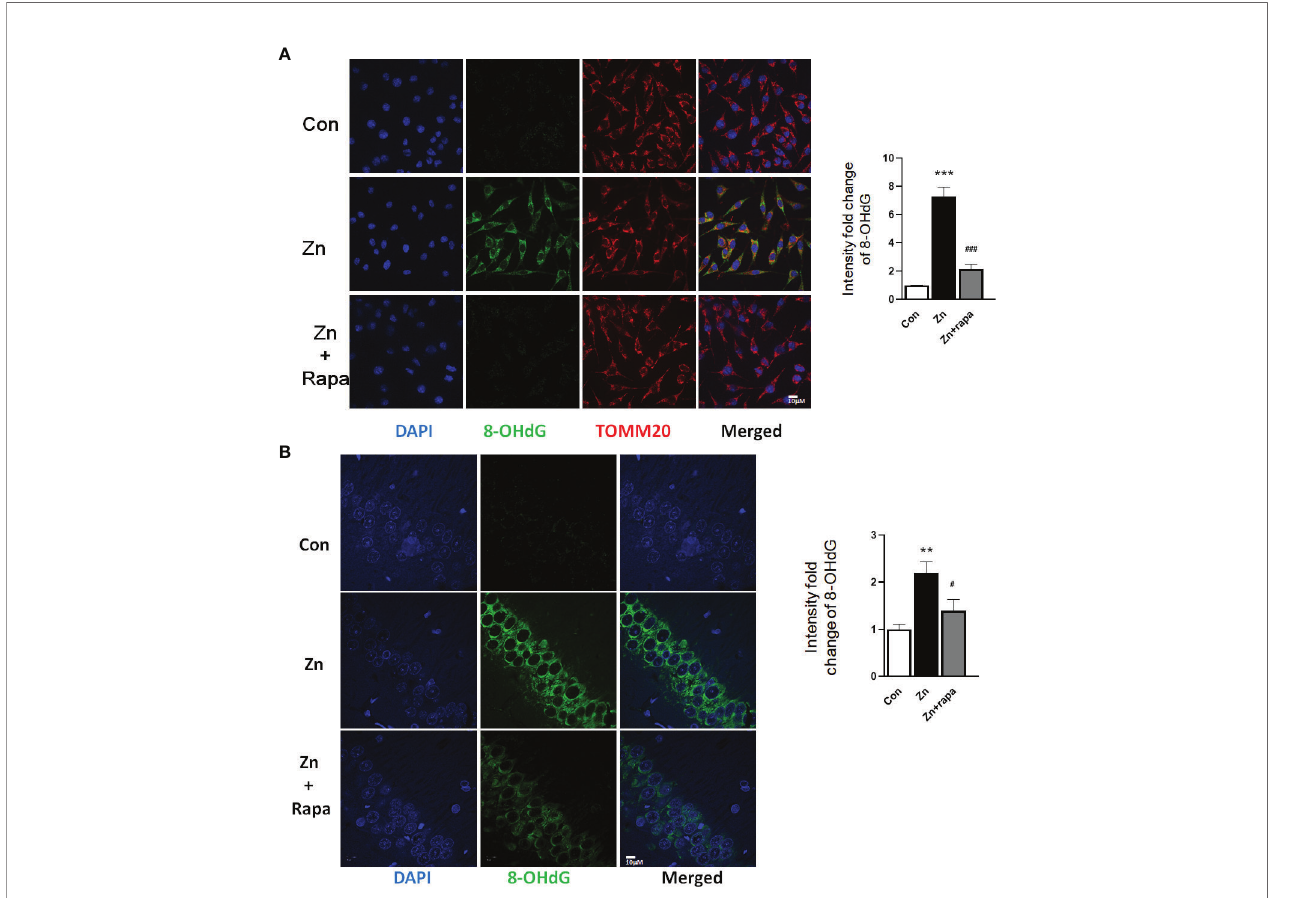
FIGURE 5 | Rapamycin prevents the DNA oxidation caused by zinc in SH-SY5Y cells and rats. (A, B) Representative confocal images and quanti fi cation of the fl uorescence intensity for immuno fl uorescence staining using anti-8-hydroxy-2 ’ -deoxyguanosine (8-OHdG) antibody (green) and anti-TOMM20 (red) in SH-SY5Y cells in the control, zinc, and zinc+rapamycin groups. Scale bar = 10 m m; nuclei were counterstained with DAPI (blue). Quanti fi cation of the fl uorescence intensity of 8- OHdG staining in the SH-SY5Y cells of the control, zinc, and zinc+rapamycin groups. n = 3 cell experiments per group. A total of 40 – 60 cells from each group were analyzed, and all confocal images are presented as the fold change relative to control cells. (C, D) Representative confocal images and quanti fi cation of the fl uorescence intensity for immuno fl uorescence staining using anti-8-OHdG antibody (green) in the CA1 areas of the brains of the rats in the control, zinc, and zinc +rapamycin groups. Nuclei were counterstained with DAPI (blue). Scale bar = 10 m m; n = 6 rats per group. All confocal images represent the fold change relative to control rats. **p < 0.01, ***p < 0.001 vs. control group; #p < 0.05, ###p < 0.001 vs. zinc+rapamycin